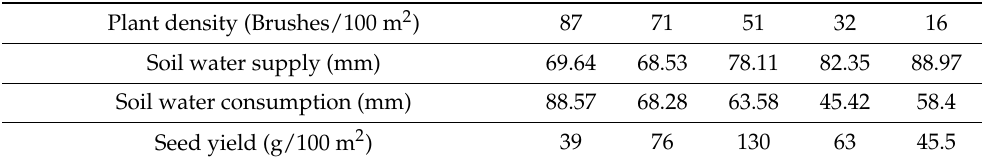
Table 2. The changes in soil water supply, soil moisture consumption, and seed yield with plant